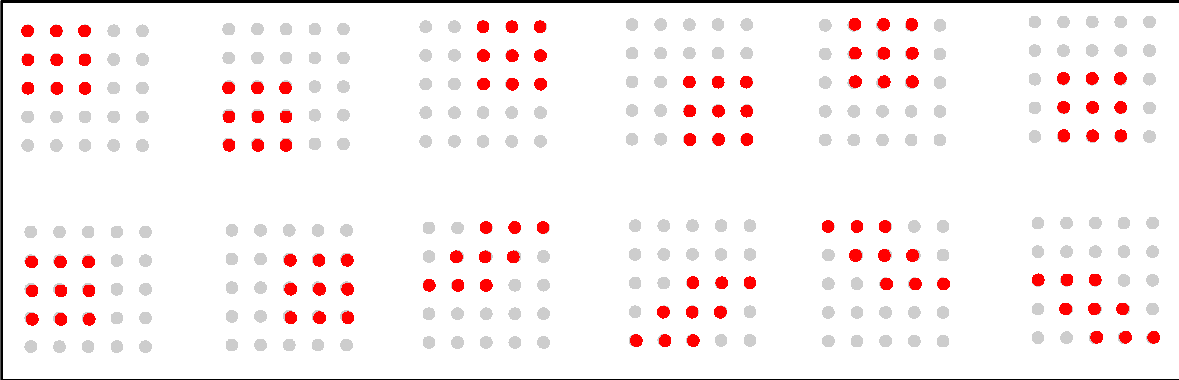
Figure 4. The Sub-domain style of SSDF method.